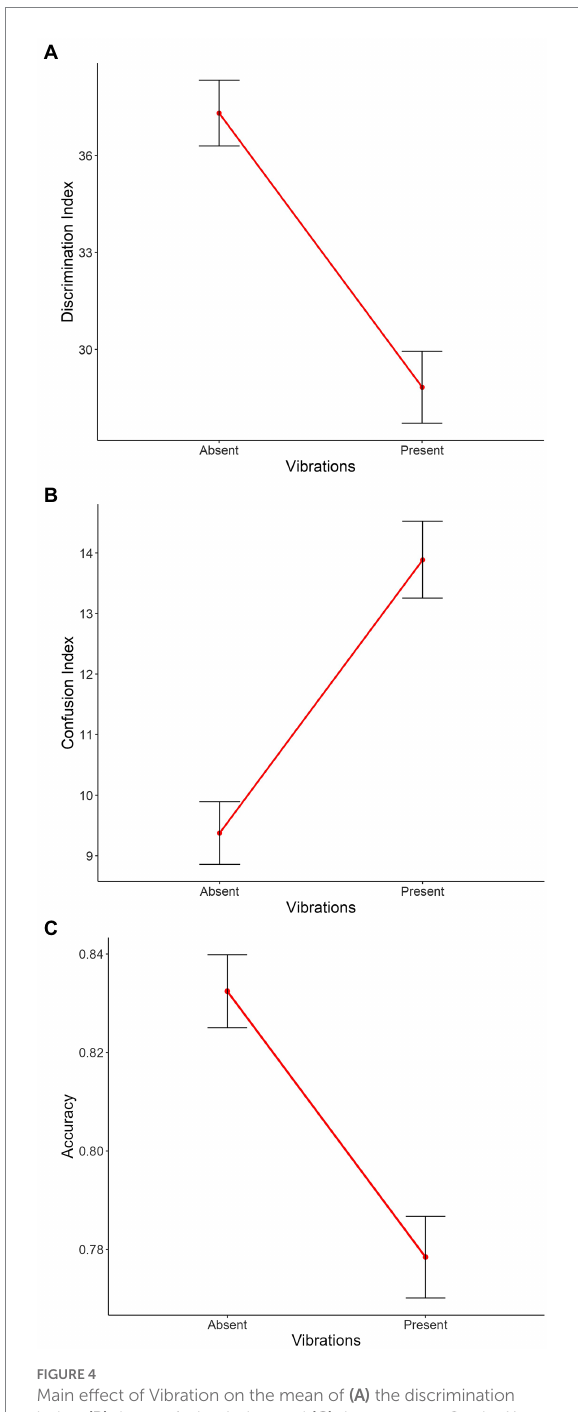
FIGURE 4 Main effect of Vibration on the mean of (A) the discrimination index, (B) the confusion index, and (C) the accuracy. On the X axis, each point represents Vibration (i.e., absent, present). Error bars indicate the standard error of the